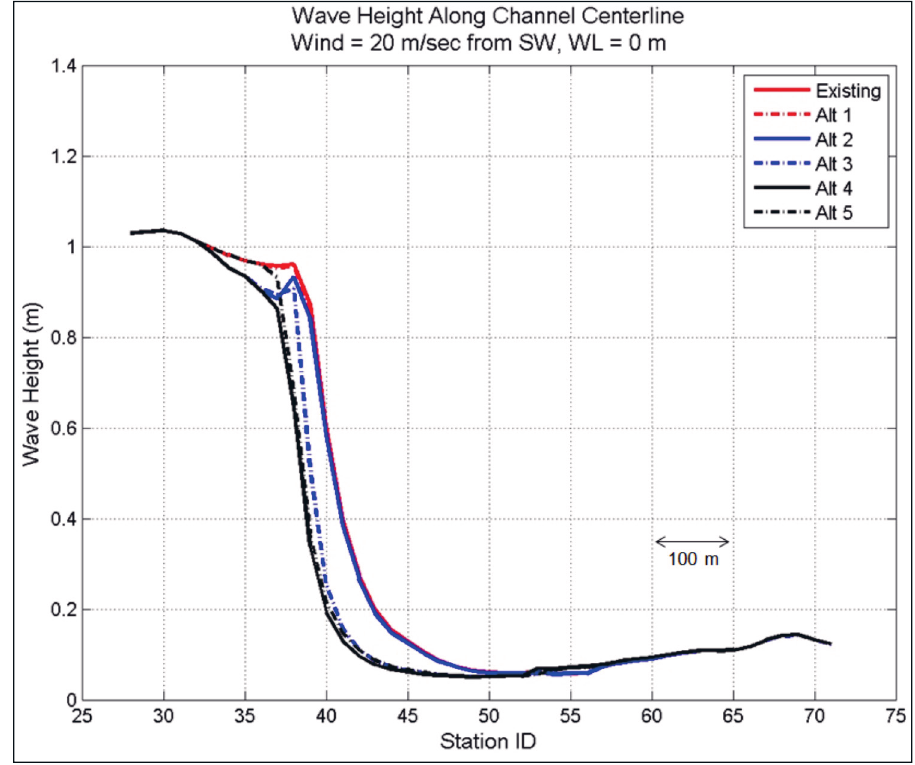
Figure 23. Model wave heights in the west channel for 50-year design wind from SW and WL = 0 m.